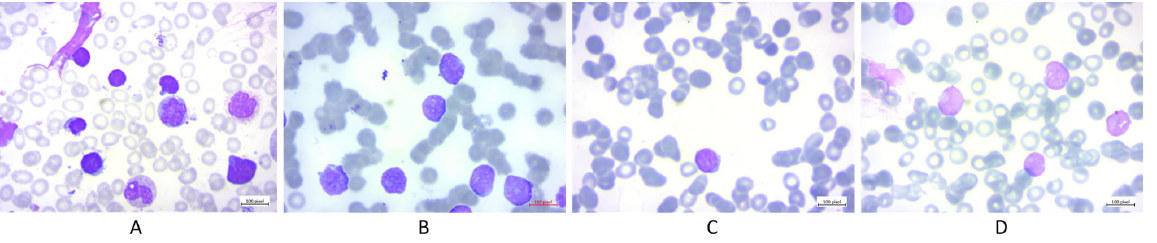
Figure 3. Samples from ALL dataset: ( A ) benign; ( B ) early Pre-B; ( C ) Pre-B; and ( D ) Pro-B.